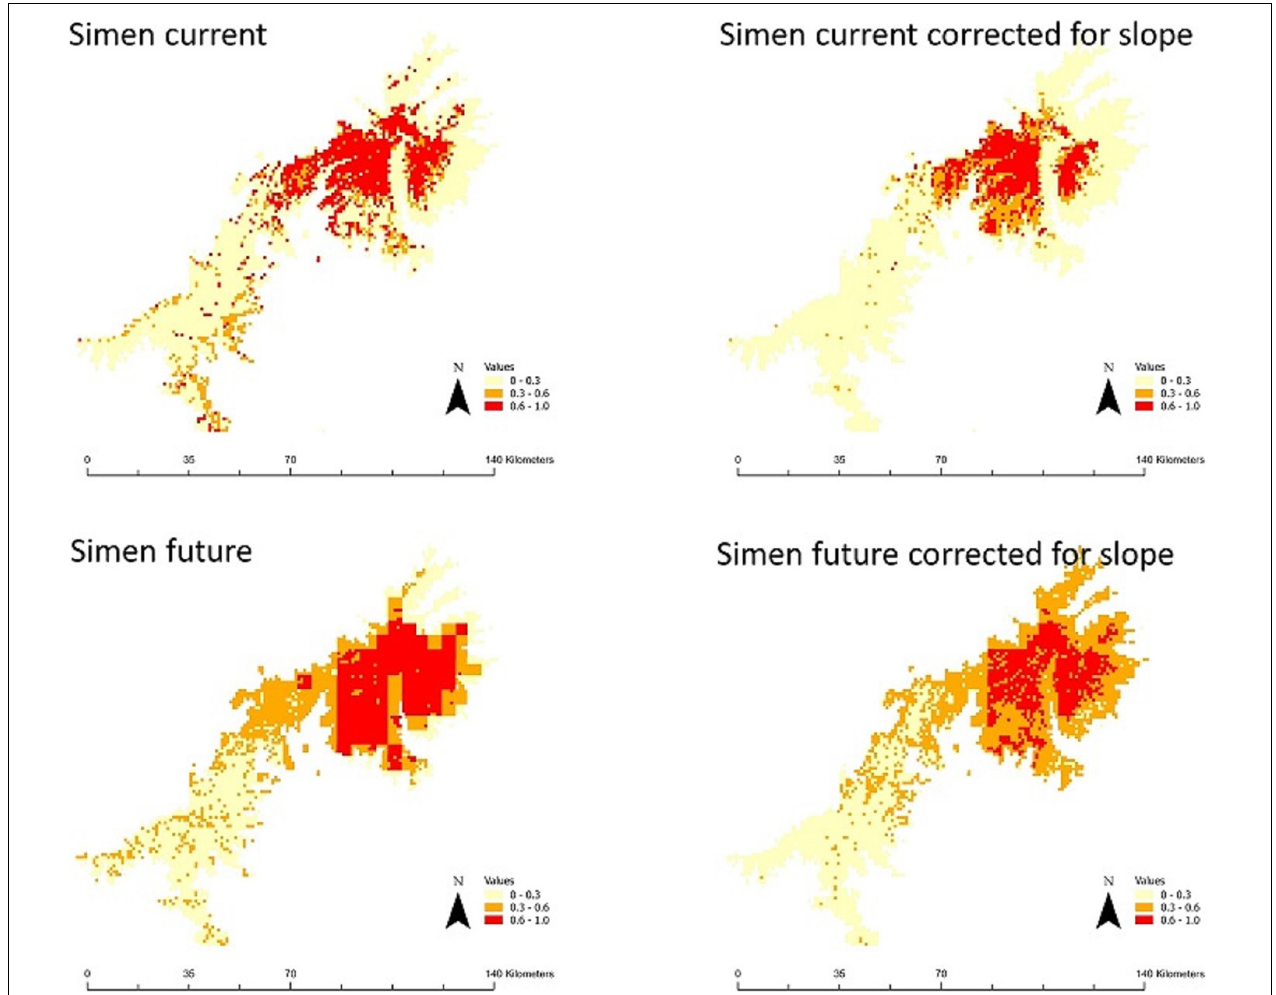
FIGURE 2 | Comparison of habitat suitability under current and future climate in the Simen Mountains. Current suitability maps are produced by averaging nine maps (3 algorithms × 3 threshold values). Future habitat suitability is produced by averaging 36 (3 algorithms × 3 threshold values × 1 climate model × 4 emission scenarios). The numbers on the legend bar refer to the degree of agreement among these maps in predicting presence: 0–0.3 unsuitable with high certainty, 0.3–0.6 uncertain suitability, > 0.6 suitable with high certainty. Slope is excluded as a predictor variable and correction is made for under-sampling of steep slopes in the maps on the right panels.